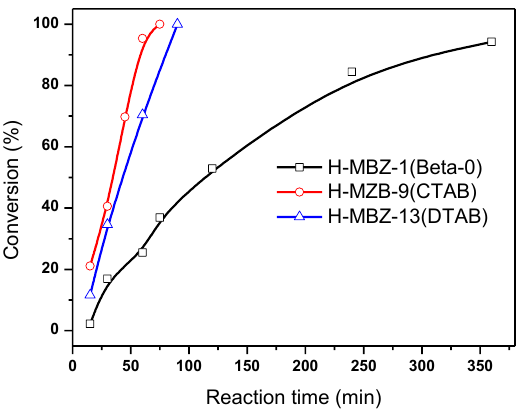
Figure 5. Benzylation of naphthalene with benzyl chloride over microzeolite Beta and hierarchical zeolite Betas.